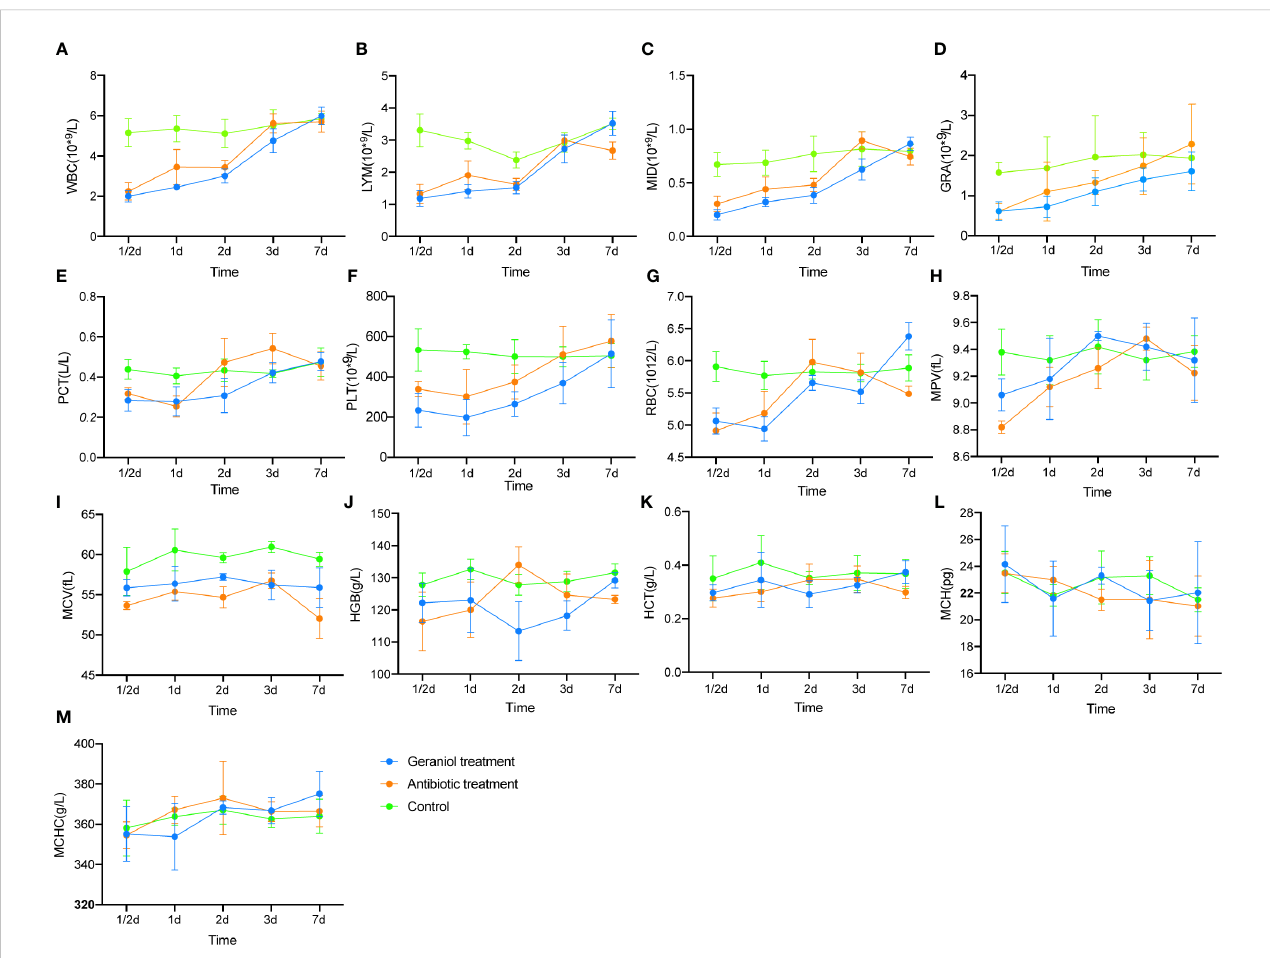
FIGURE 1 Effect of geraniol and antibiotics on the recovery of Blood Routine Indexes in mice with bacterial infection. (A) white blood cell count (WBC); (B) absolute lymphocyte value (LYM); (C) absolute intermediate cell (MID); (D) absolute granulocyte value (GRA); (E) platelet packed volume (PCT); (F) platelet count (PLT); (G) red blood cell count (RBC); (H) average platelet volume ((MPV); (I) mean red blood cell volume (MCV); (J) hemoglobin (HGB); (K) hematocrit (HCT); (L) mean hemoglobin content (MCH); (M) mean hemoglobin concentration (MHCH). h means hours; d means